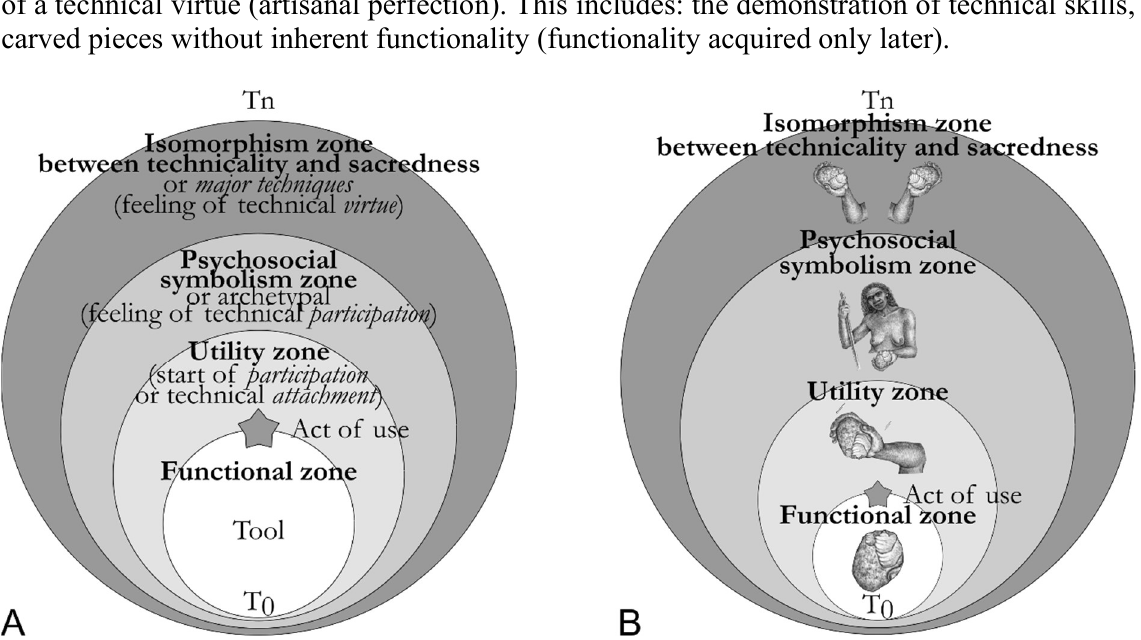
Figure 8. Psychosocial topology of the technical object. Left, concentric zones of industrial objects Simondon (2014: 52-64). Right, our proposal for concentric zones of prehistoric tool. T0, trajectory initial time; Tn, trajectory of final time. Gray levels correspond to the degree of purity (in the sense of technicality) of the object: the grayer the area, the more contaminated (culturally) the technical object